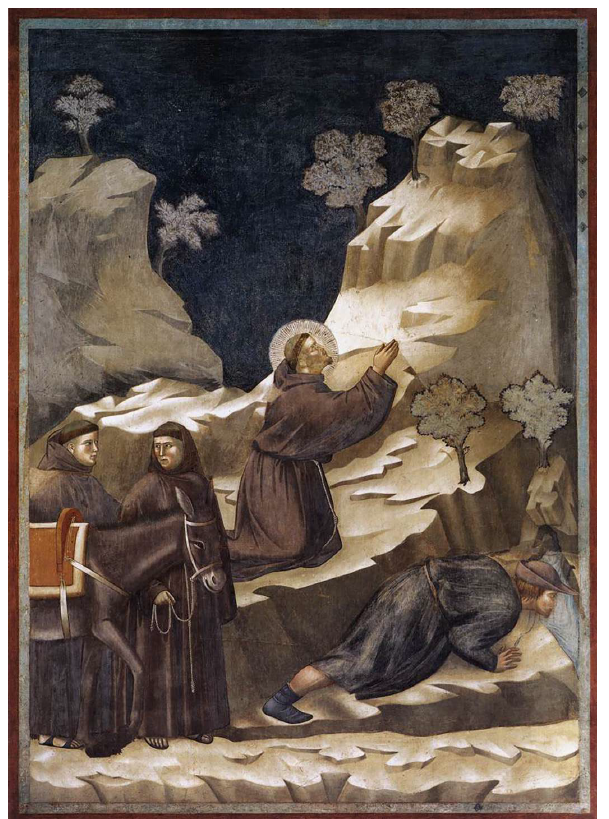
Figure 20. The legend of St. Francis – miracle of the spring (1297– 1300). Upper Church, Assisi, Italy. Note the realistic depiction of the wave-like marks of erosion along the bedding planes of the strat- ified limestone. Source: public domain – Wiki